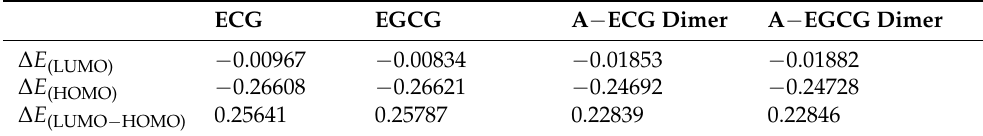
Table 2. The highest occupied orbital energy, the lowest empty orbital energy, and the difference between the two (a.u.).